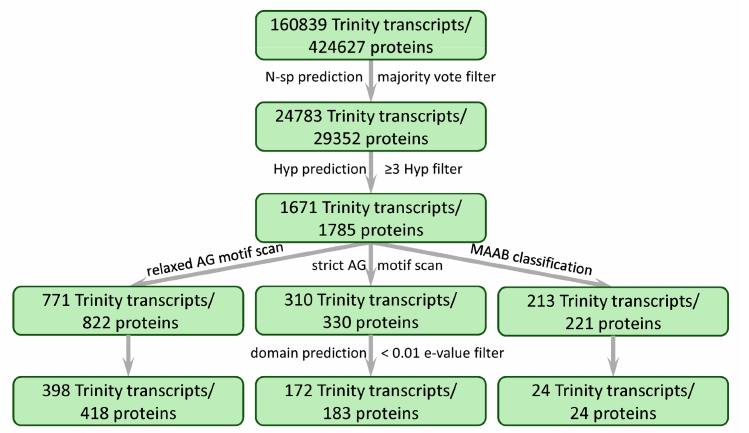
Figure 1. The number of C. erythraea Trinity transcripts and predicted protein sequences passing through different filters of the ragp pipeline.